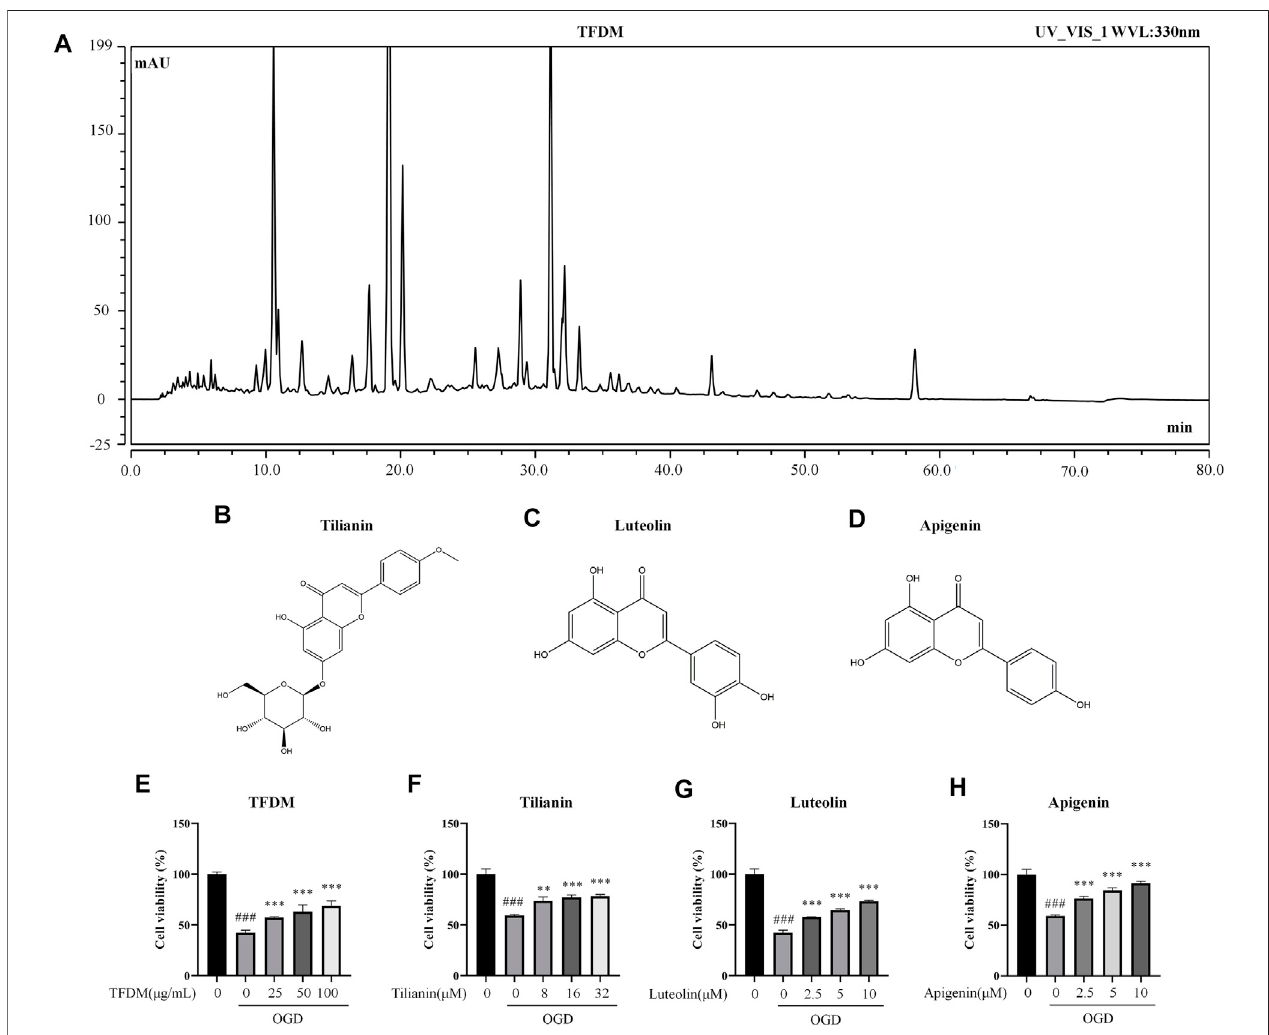
FIGURE9| FingerprintofTFDM,compoundstructures,andneuroprotectiveeffectsofTFDMaswellasactivecompoundsonneuronalcellsagainstOGDinjury. (A) HPLC chromatogram at 330 nm for TFDM. (B – D) Structure of tilianin (B) , luteolin (C) , and apigenin (D) . (E) Improved cell viability of SH-SY5Y cells by TFDM after the exposuretoOGD. (F – H) ImprovedcellviabilityofSH-SY5Ycellsbytilianin (F) ,luteolin (G) ,andapigenin (H) aftertheexposuretoOGD.Statisticalanalysiswasperformed using one-way ANOVA followed bya Tukey ’ smultiple comparison test. n (cid:2) 3. ### p < 0.001 vs . control; ** p < 0.01, *** p < 0.001 vs . OGD. Results are expressed as mean ±